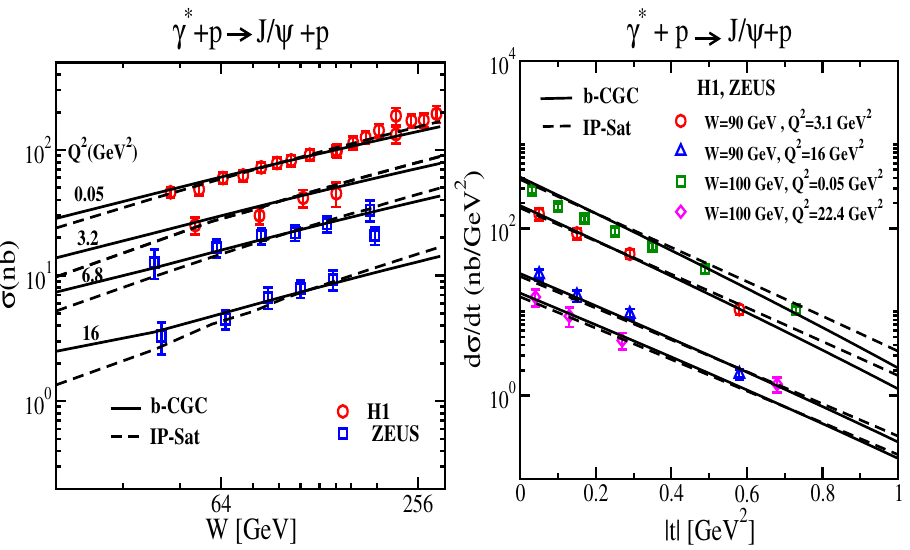
Figure 16. J / ψ exclusive electroproduction data from HERA compared to saturation models (bCGC t and IPsat). ( Left ) energy dependence. ( Right ) spectra. Figure from the work in [54]. | | One of the consequences of saturation is a steeper t -distribution compared to one obtained from the form factor or Fourier transform of the density profile [75]. This has recently received some attention [76] in light of the very precise ALICE measurements of J / ψ photo-production at very low t [77] as shown in Figure 17. Note that even after saturation is included as in the model in [78], the spectrum is not steep enough to reproduce the lowest t